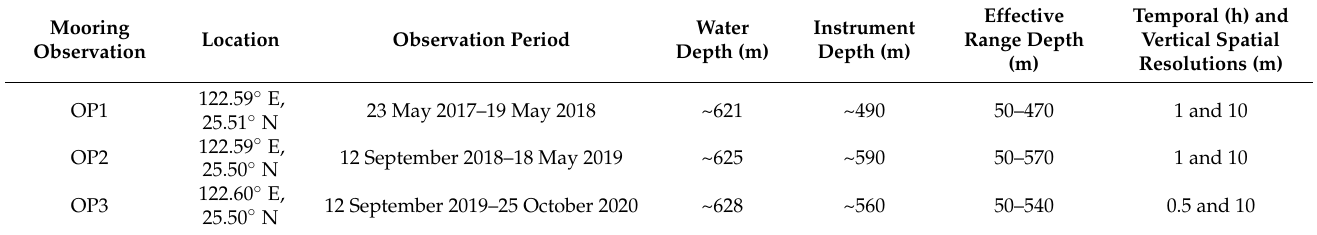
Figure 1. ( a ) Bathymetry (color) off northeastern Taiwan and average location of the mooring (magenta star). The thin gray lines indicate the 200 m, 400 m, 800 m, and 1000 m isobaths, and the thick black line indicates the 600 m isobaths. The red arrows denote the mean sea surface geostrophic currents during the whole observation period. ( b ) Histogram of the number of observation days in each month. Table 1. Detailed information on the three mooring observations (OP1–OP3) after linear interpolation.